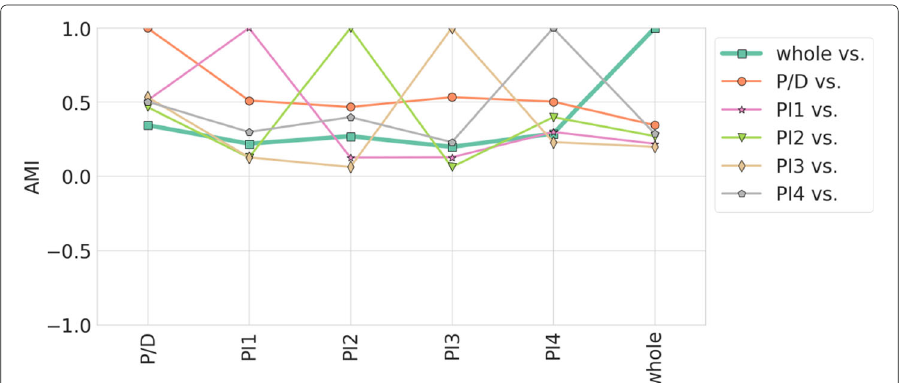
Fig. 6 Pairwise Adjusted Mutual Information of graphs’ clusterings